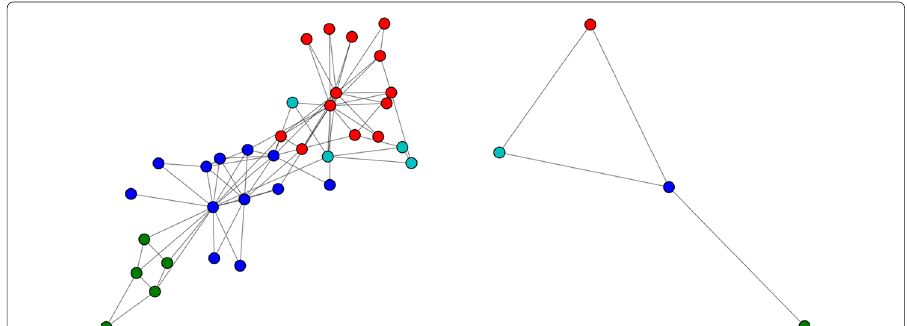
Fig. 1 Visual Analitycs. Network Visualization for communities obtained with Louvain method on the Zachary’s Karate Club graph. CD LIB allows to: (left) visualize communities on the original graph by identifying them using the same color palette for the nodes; (right) collapse each community in a single node and visualize the community connection graph